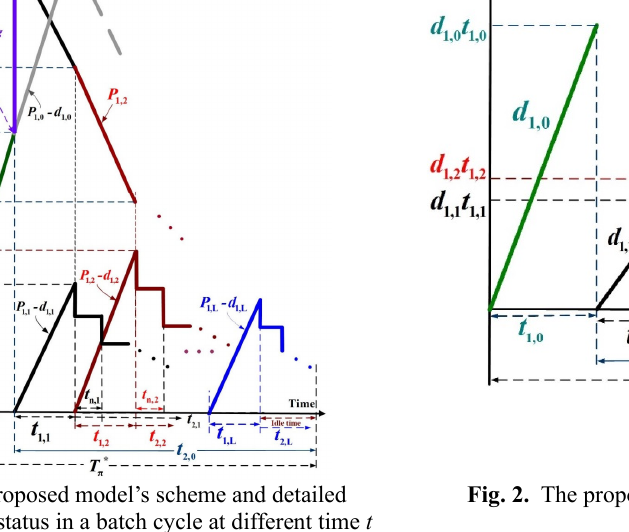
Fig. 1. The proposed model’s scheme and detailed stock status in a batch cycle at different time t compared with the same system without subcontracting option (in grey)